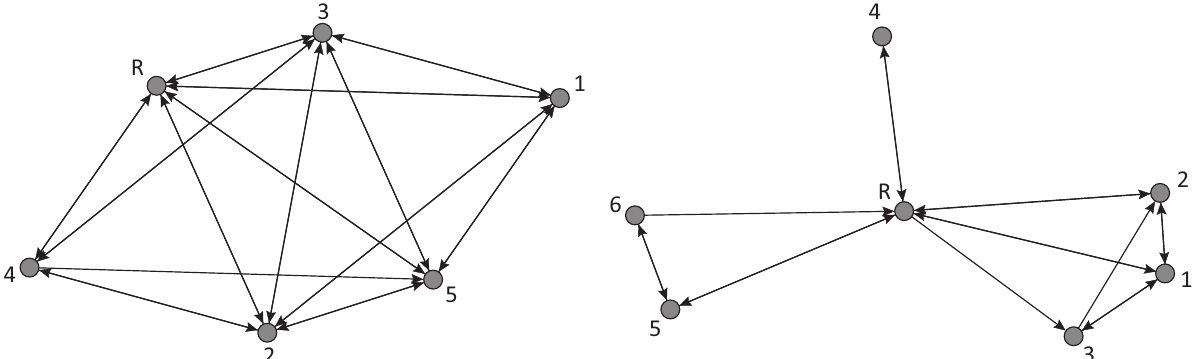
Figure 1. Bonding and bridging social capital. Reading: An arrow from A to B indicates that A provides emotional support to B (from the respondent R’s point of